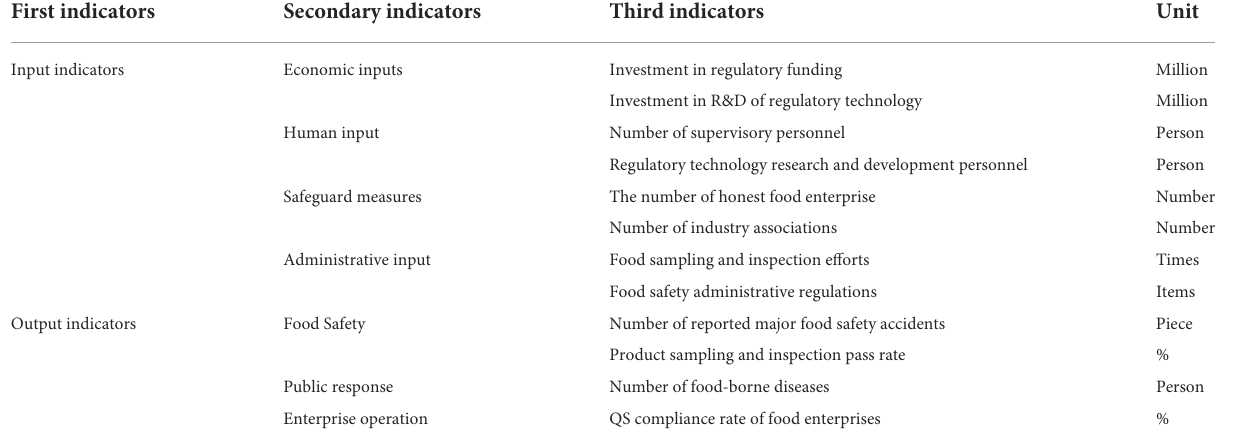
TABLE 1 Food safety supervision efficiency evaluation index